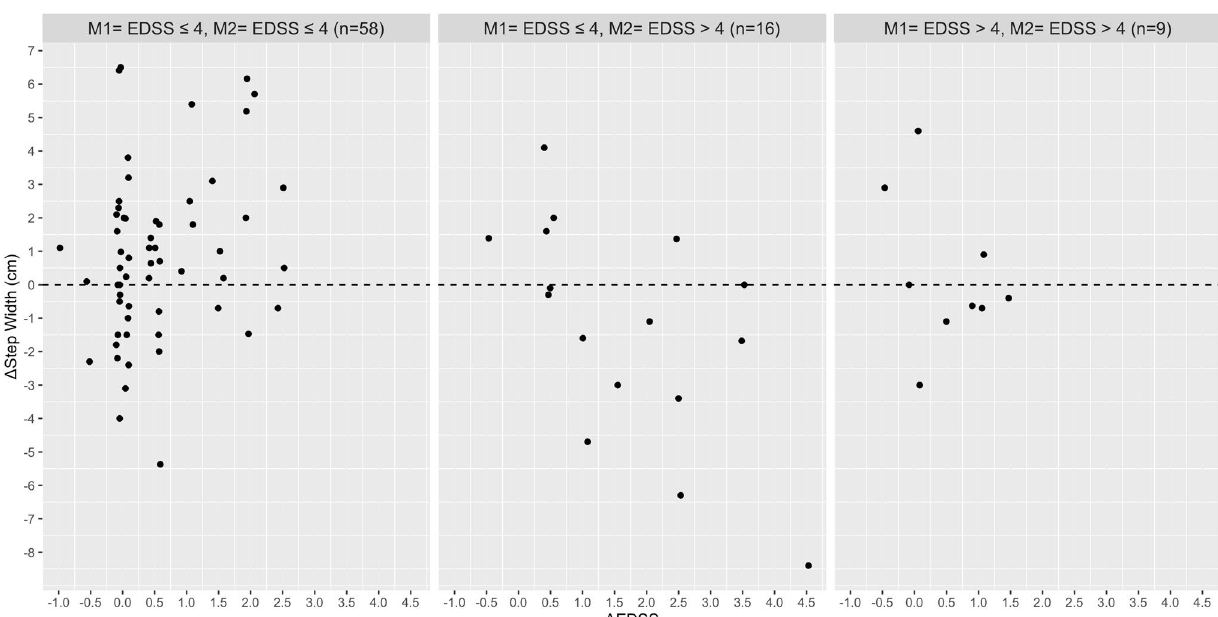
Figure 4. Relationship between the absolute change in step width with absolute change in the EDSS score according to disability